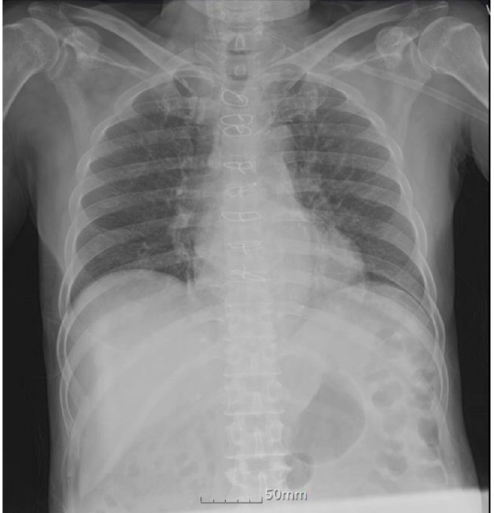
Figure 2. Chest radiography showed non-specific infiltrations at both lower lungs.